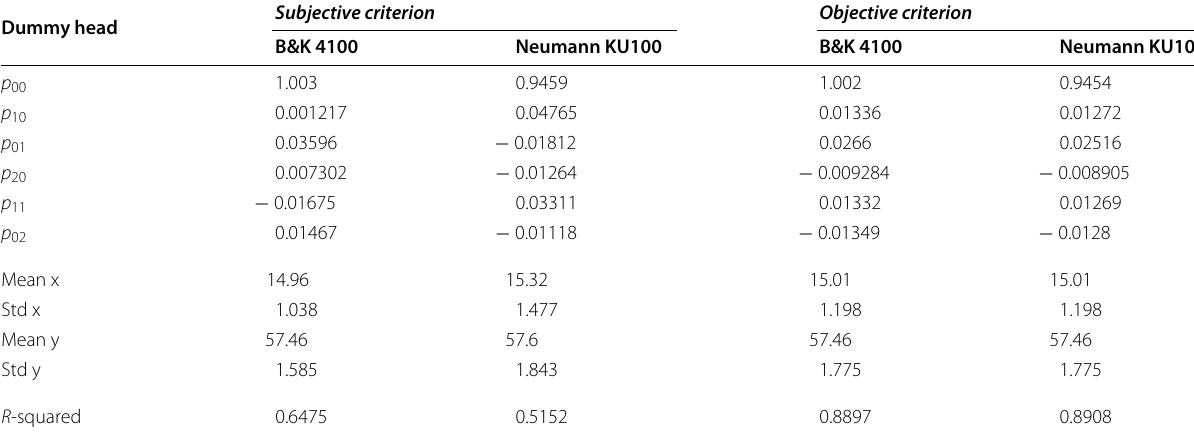
Table 5 Normalized coefficients of the polynomials, for the scaling of the ITD of the two dummy heads. x is intertragus distance and y is the perimeter of the head